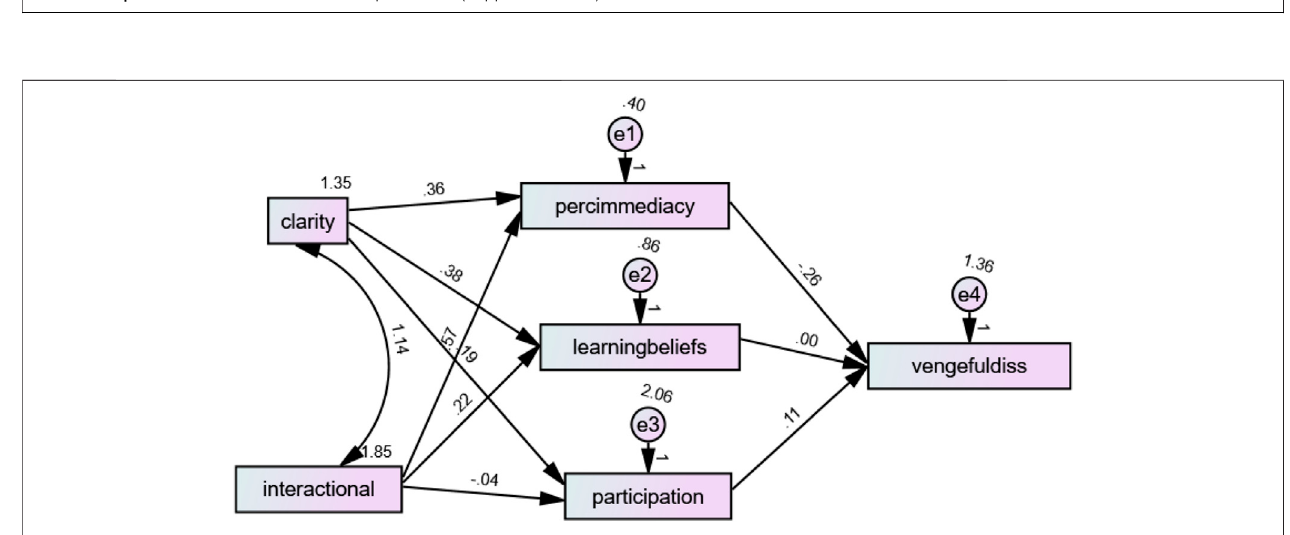
FIGURE 6 | Vengeful dissent with class preference (Supported model).